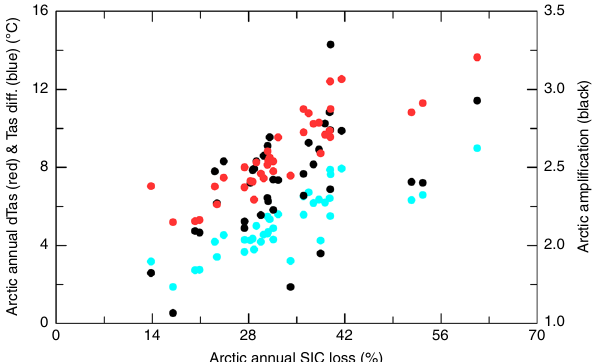
Fig. 4 Dependence of Arctic warming and ampli fi cation on sea-ice loss among 38 CMIP5 models. Scatter plot of 2070 – 2099 minus 1970 – 1999 difference under the RCP85 scenario between annual Arctic SIC loss and Arctic surface warming (red), Arctic-minus-global warming difference (blue), or the Arctic-to-global warming ratio (i.e., the Arctic ampli fi cation, or AA, black). Each dot is for one CMIP5 model. Correlation coef fi cients: r(SIC, dTas_Arctic) = 0.87 ( p = 0.00), r(SIC, Tas_diff) = 0.84 ( = 0.00), and r (SIC, AA) = 0.54 ( p = 0.01)